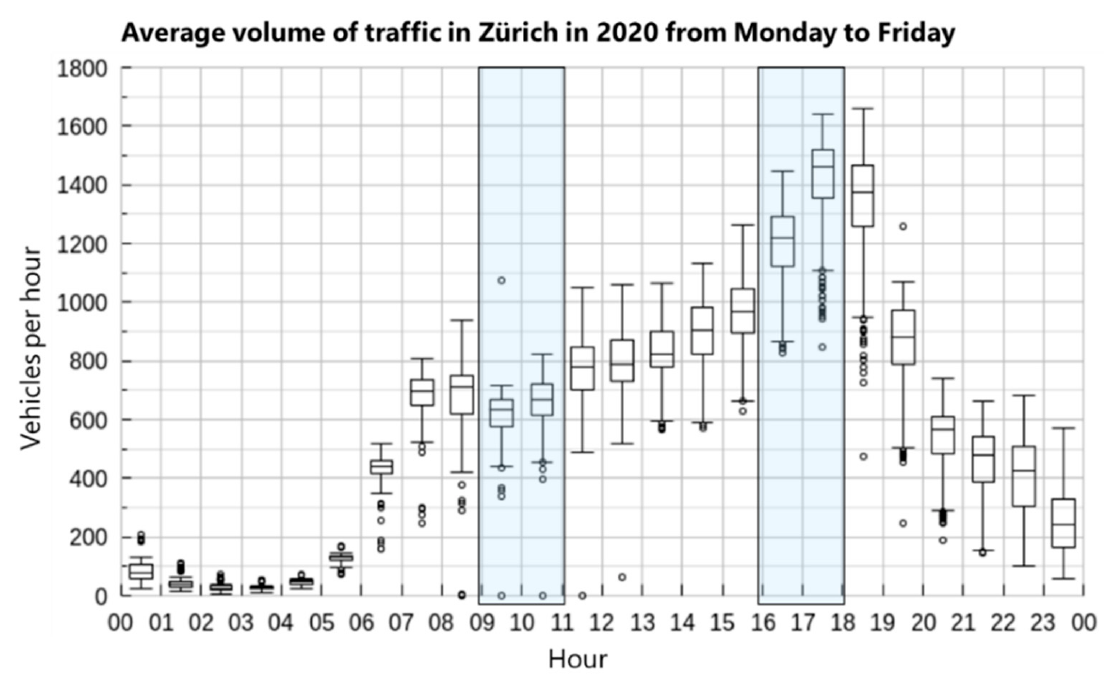
Figure 2. Average daily road traffic counts (vehicles per hour) at a measurement location in central Zurich in the year 2020 with the hours where the measurements took place highlighted. Source of data: City of Zurich (2021).